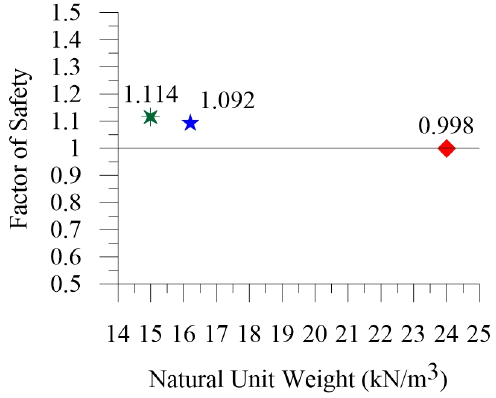
Figure 13. Factor of safety variation versus natural specific weight.